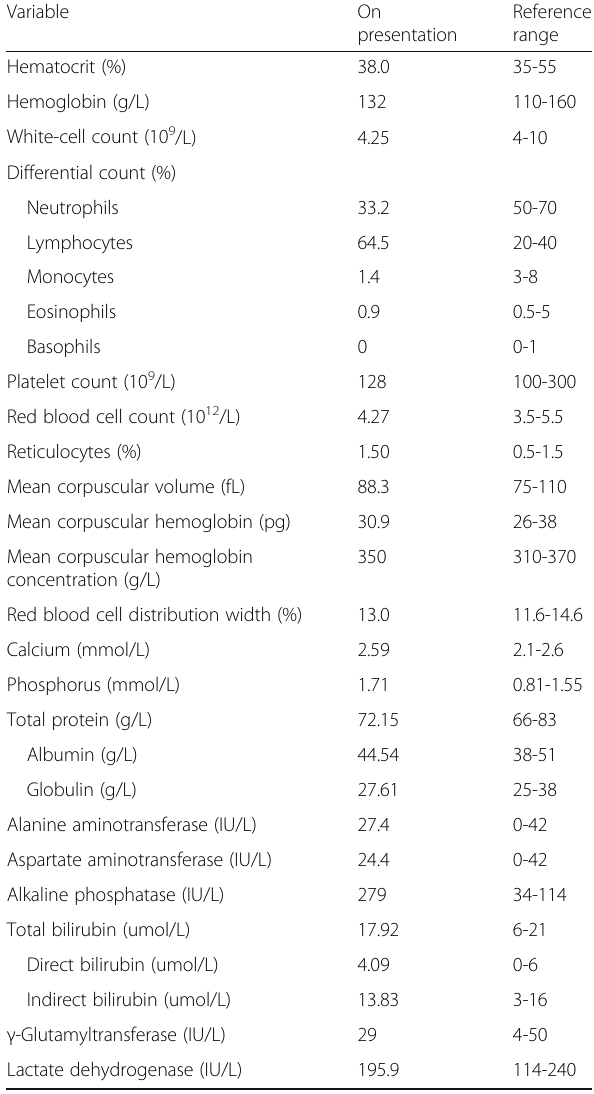
Table 1 Laboratory data on